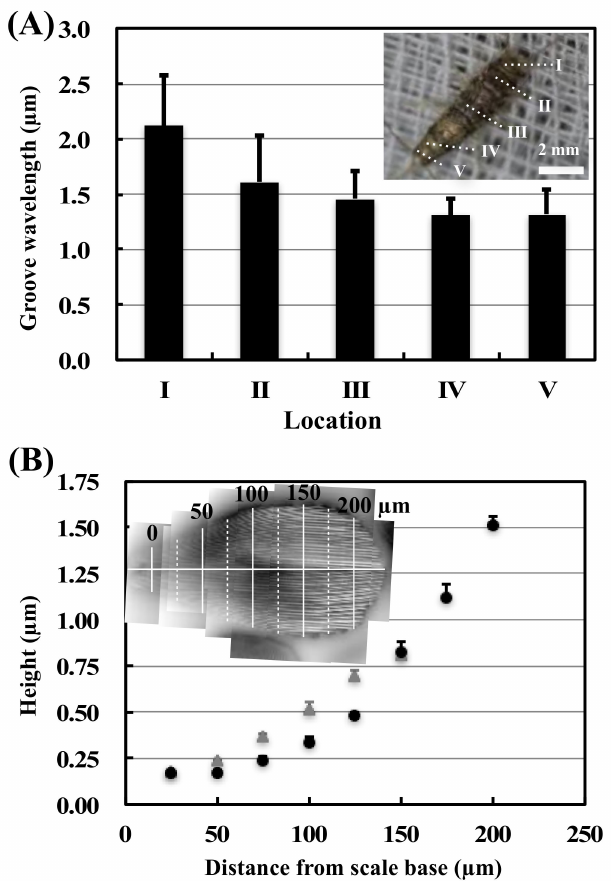
Figure 2. Graphs of structural variations of firebrat scales. ( A ) Groove wavelengths of firebrat scales (mean ± standard deviation) for the different body regions: head (I); pronotum (II); metanotum (III); 8th abdominal tergum (IV); and 9th abdominal tergum (V). ( B ) Groove height measured from the scale base to the apex. Data shown present the average height of three scales with a groove wavelength of ca. 3.5 µ m (black) and three scales with a groove wavelength of ca. 2.0 µ m (gray). Error bars represent the standard deviation. The inset shows a stitched image of AFM topographies. White lines indicate the positions of the grooves’ measuring